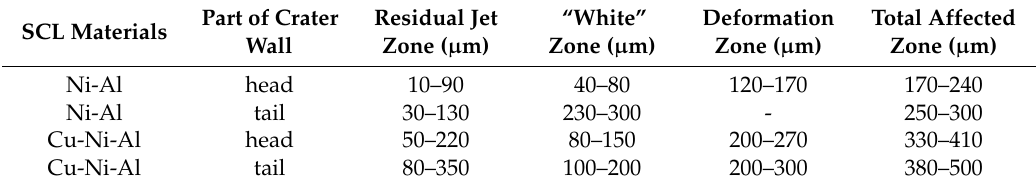
Figure 7. The microstructure of the crater walls penetrated by Ni-Al reactive shaped charge liner. ( a ) the head of the crater walls (100×); ( b ) the tail of the crater walls (100×); ( c ) the head of the crater walls (200×); ( d ) the tail of the crater walls (200×). Table 4. The thickness parameters of the affected zones penetrated by two kinds of